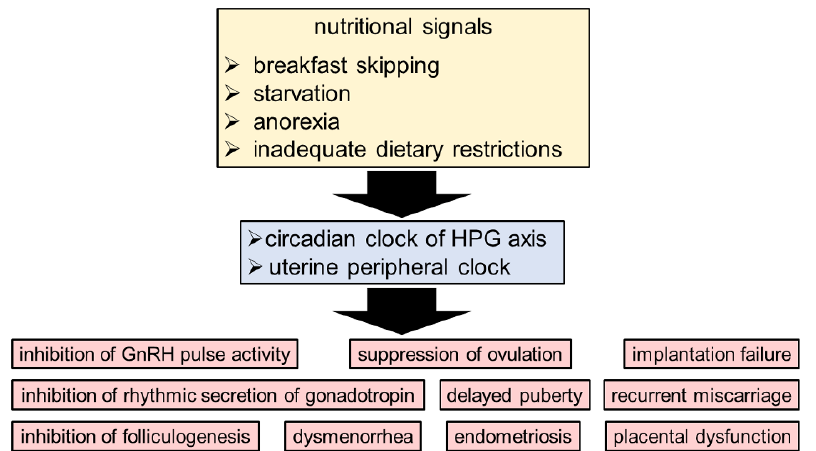
Figure 2. The circadian clock system as a relationship between reproductive health and nutritional signals. The circadian rhythm in the HPG axis and uterus is negatively impacted by nutritional signals such as skipping breakfast, starvation, anorexia, and inadequate dietary restrictions.